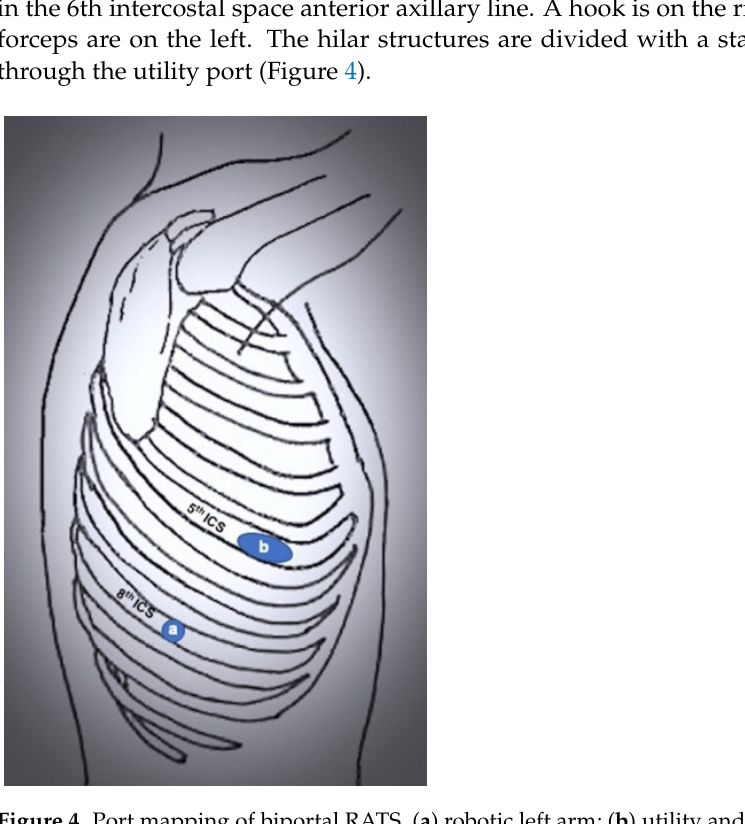
Figure 4. Port mapping of biportal RATS. ( a ) robotic left arm; ( b ) utility and camera port. According to Yang et al. [8], a uniportal RATS can be performed through a single, 4 cm incision in the 4th intercostal space midaxillary line. A 30° camera is placed at the upper end of the incision, and two other robotic arms (forceps and hook) are placed in the upper two-thirds of the incision. At the lower end, a 1.5 cm space is left for the assistant to help.